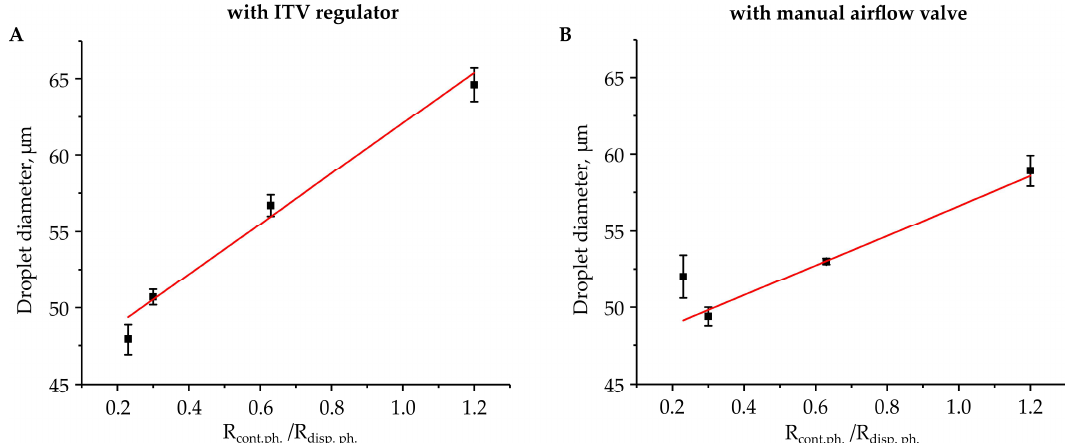
Figure 4. Droplets diameters as a function of the ratio between the hydrodynamic resistances of the continuous and the dispersed phases, R con.ph. /R disp.ph . Droplet generation was performed in the setup with ( A ) the ITV regulator and ( B ) the manual airflow control valve. The pressure in the outlet reservoir was set to −50 kPa, when droplets diameter was insensitive to its value. Error bars indicate standard deviation.